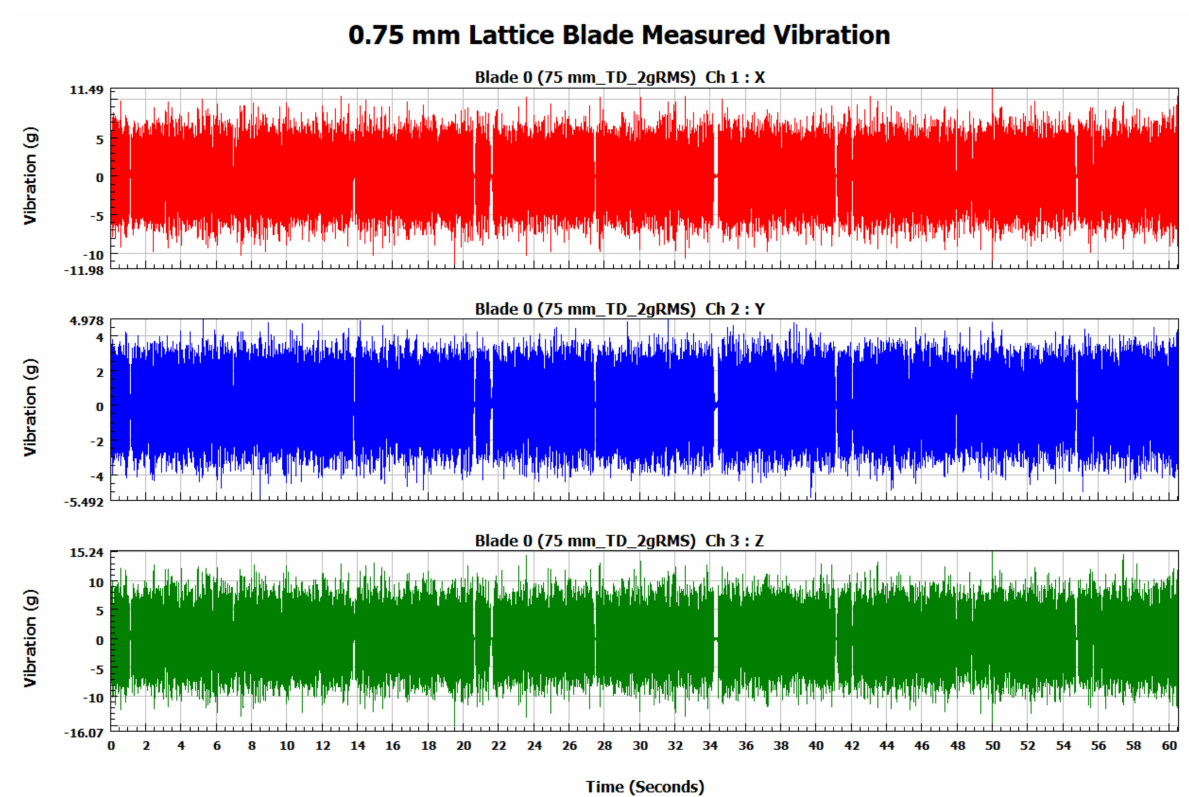
Figure 11. The 0.75 mm lattice blade measured vibration signal in the time